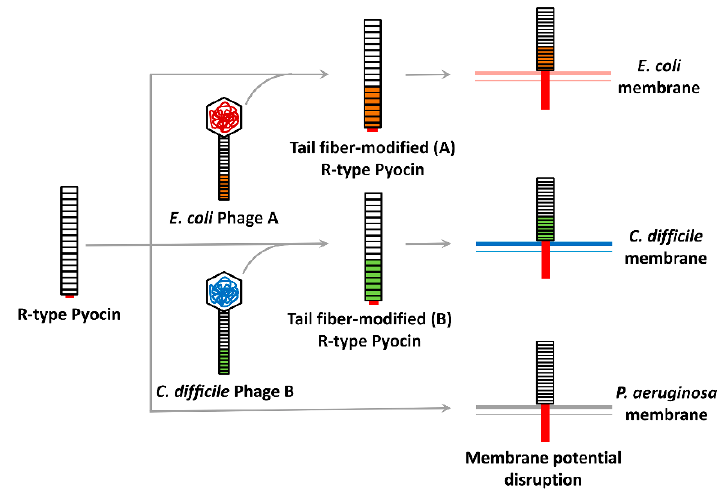
Figure 3. Pyocin engineering strategy and mode of action. The target of an R-type pyocin can be shifted from Pseudomonas aeruginosa to Escherichia coli or Clostridium difficile by tail shuffling. The tail fibers of either ( A ) E. coli phage or ( B ) C. difficile phage are fused to the R-pyocin, resulting in modified R-pyocins that can bind to respective target bacterial membranes. Once the modified R-pyocins reach each hosts’ membranes, sheath contraction induces core tube penetration and disrupts the membrane potential (red bars).